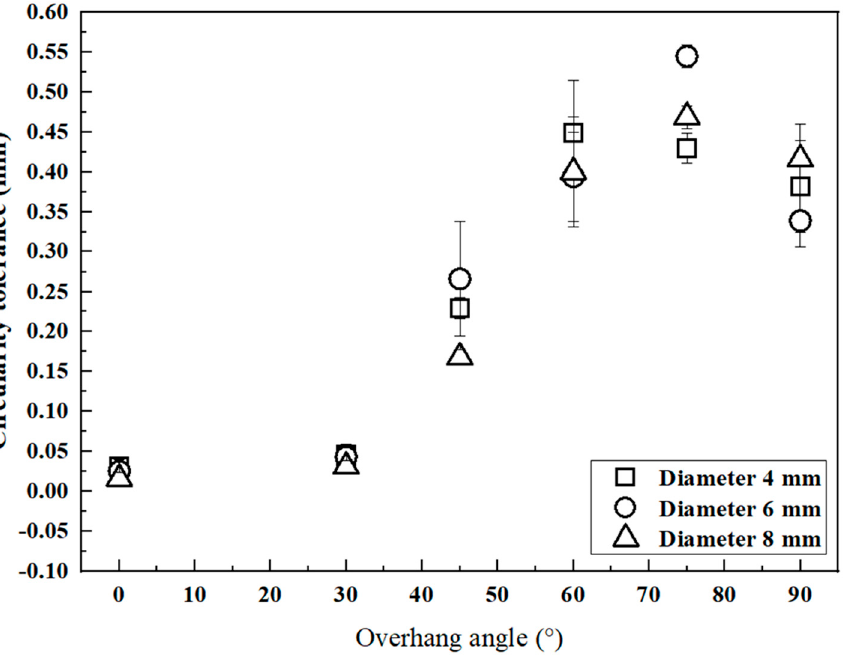
Figure 8. Circularity tolerance plot reporting the values averaged on both the three depth values for each hole and the three structures considered for repeatability (standard deviation is indicated as ± σ